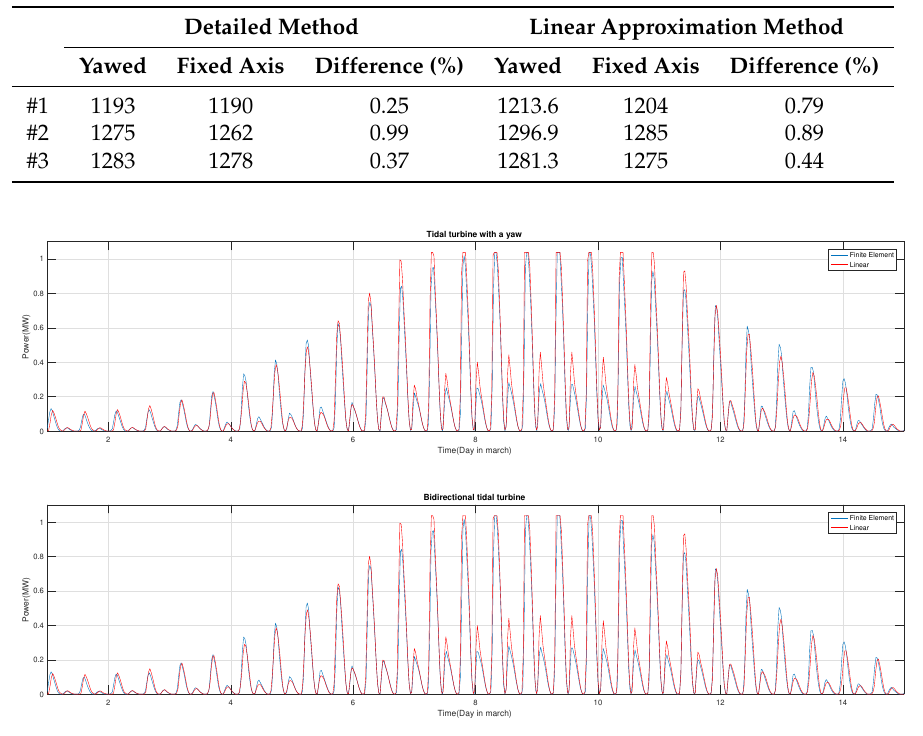
Figure 10. Time series of the predicted power production for yawed and fixed-axis turbines at point